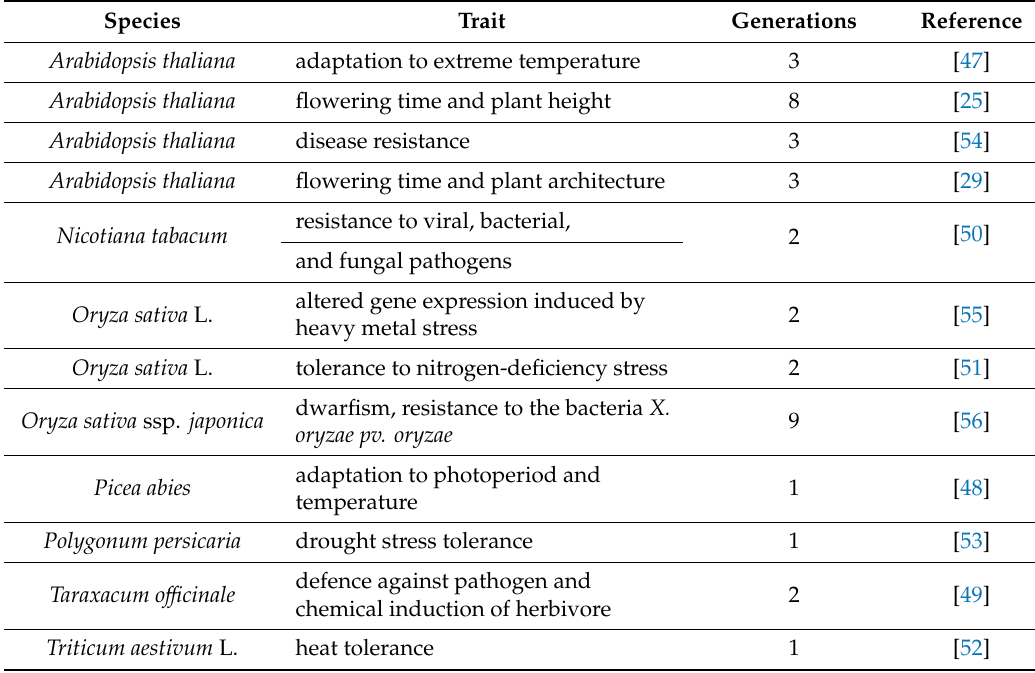
Table 2. Examples of DNA methylation transmission studies in plants. Species Trait Generations